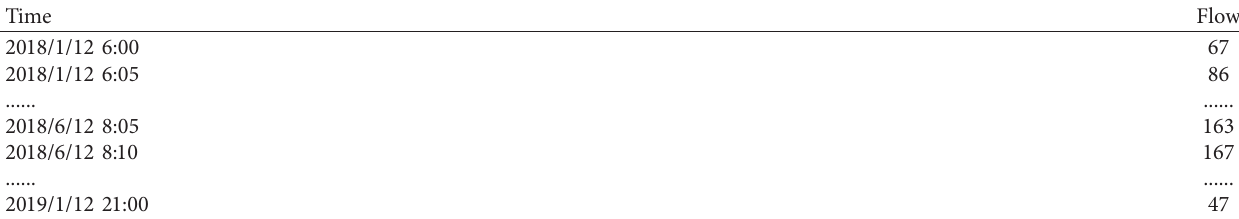
Table 1: Traffic flow dataset (processed).